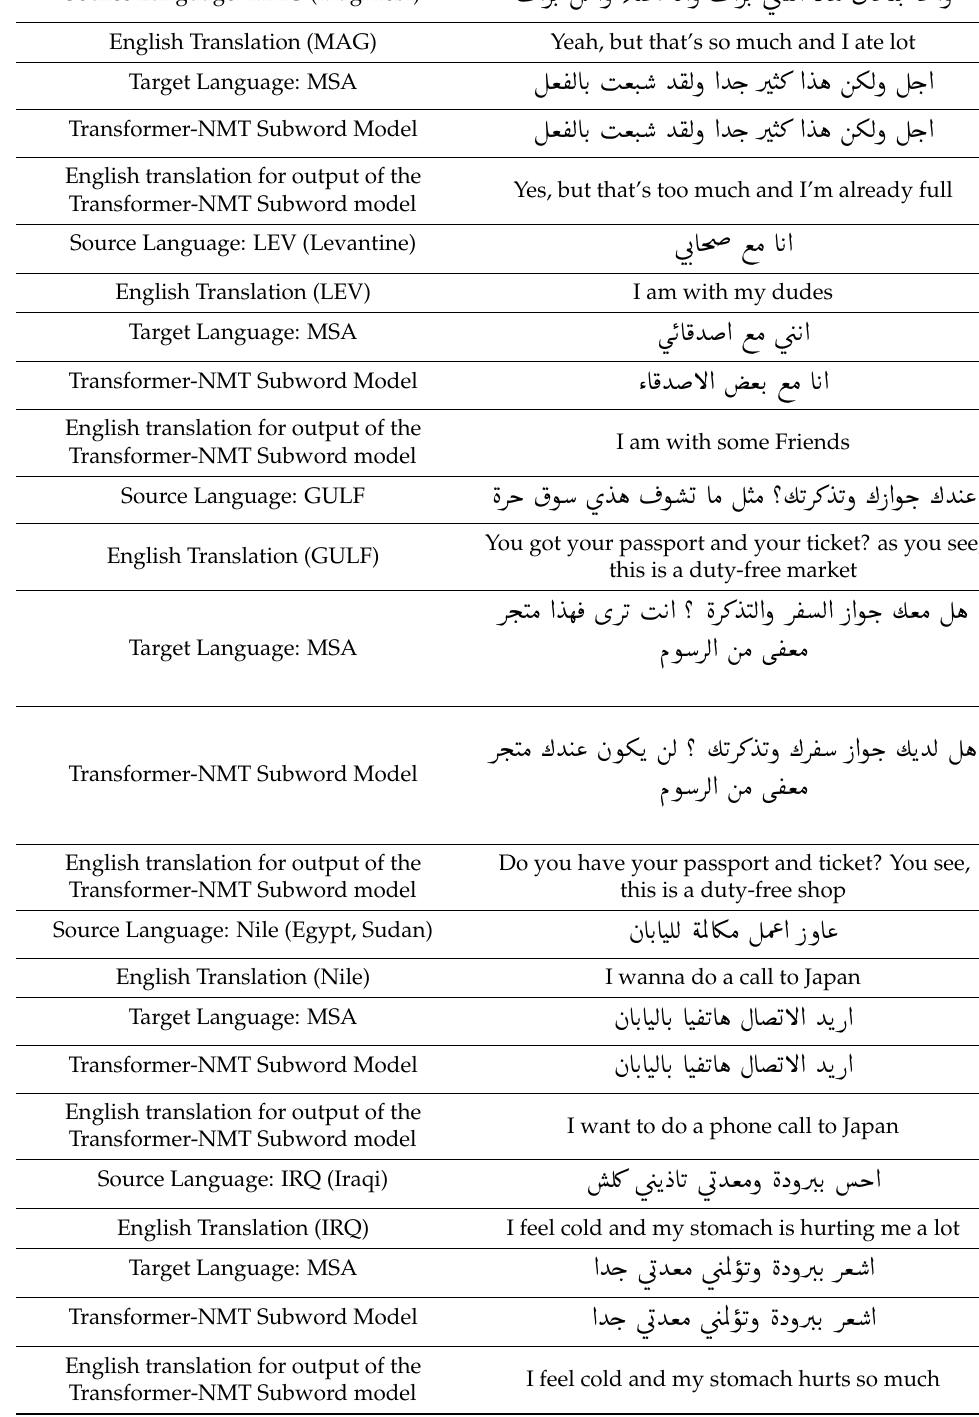
Table 11. Translation Examples for MAG, LEV, NILE, GULF and